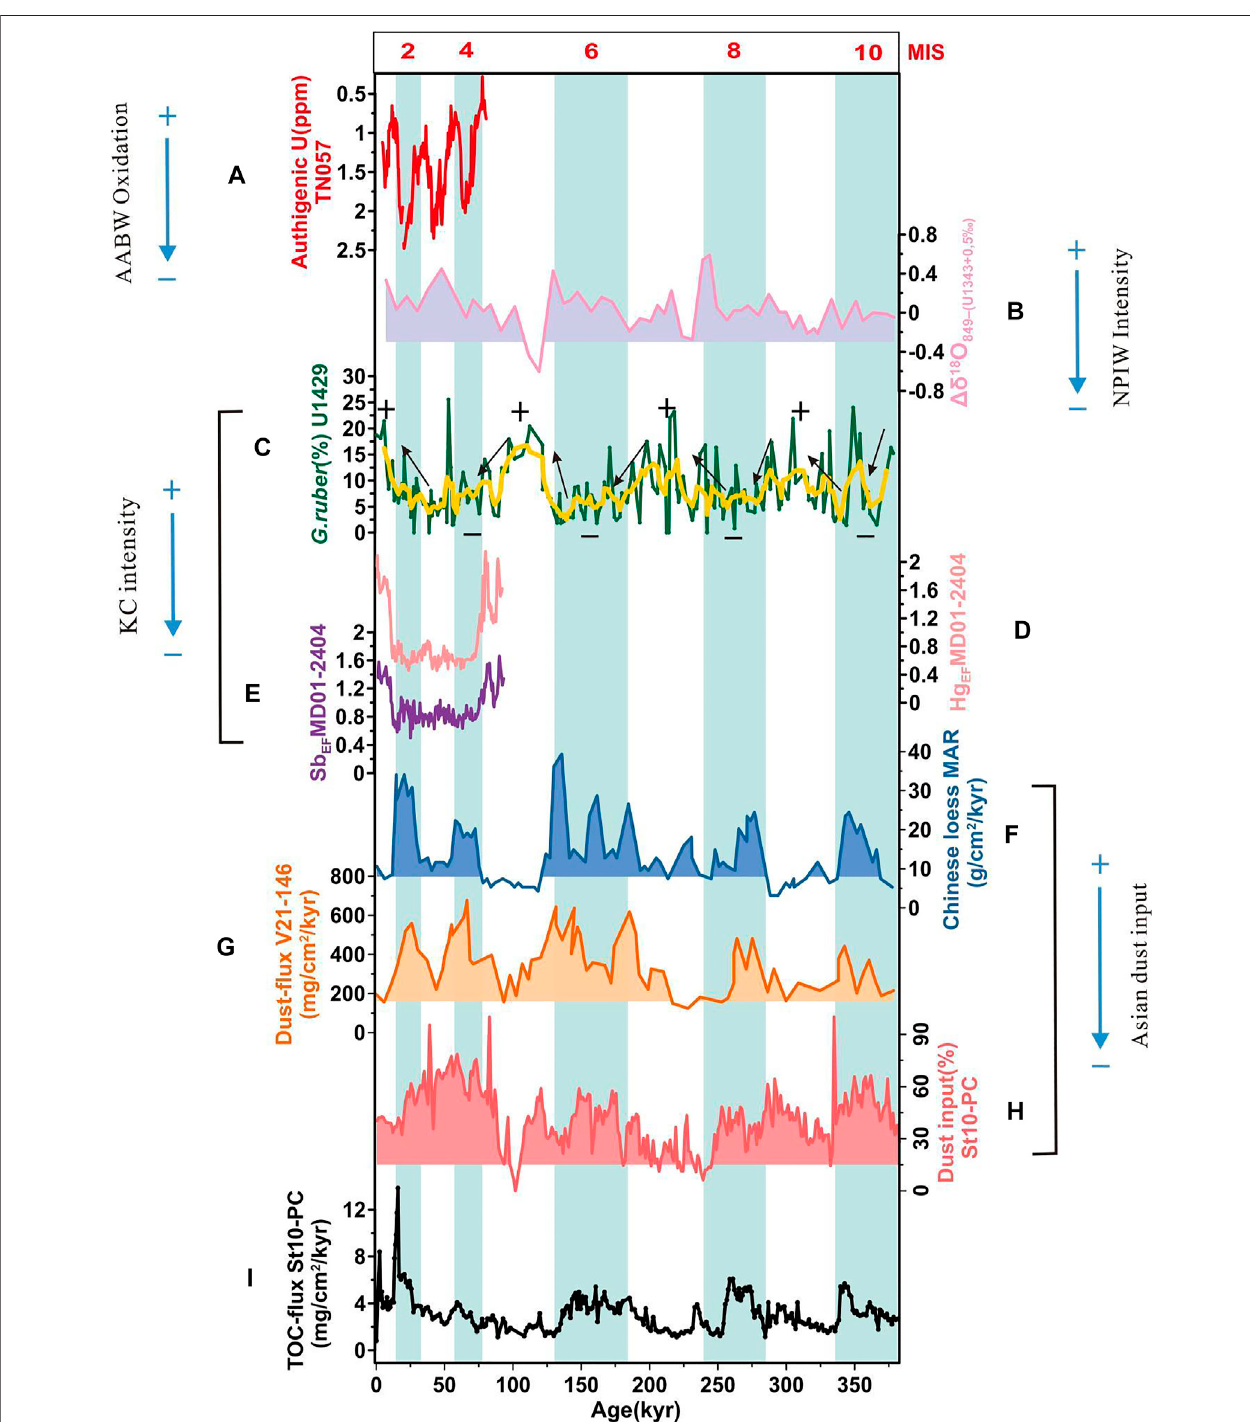
FIGURE 5 | Comparison of records of OC burial in core St10-PC with Asian dust input, KC intensity, NPIW variation, and AABW oxidation. (A) Antarctic Bottom Water oxidation determined by authigenic uranium of core TN057 (Jaccard et al., 2016), (B) North Paci fi c Intermediate Water intensity determined by Δδ 18 O between core849andcore1343(Worneetal.,2019), (C) KuroshioCurrentintensityproxyof G.ruber contentsofcoreU1429(Vatsetal.,2020), (D,E) KuroshioCurrentintensity determined by sedimentary Hg and Sb ofcore MD01-2404 (Zou et al., 2021), (F) Chinese Loess fl uxes (Sun an An, 2005), (G) dust- fl uxes of core V21-146 (Hovan et al., 1989), (H) dust input variables of core St10-PC, (I) OC fl uxes of core St10-PC; blue shadow: glacial periods.